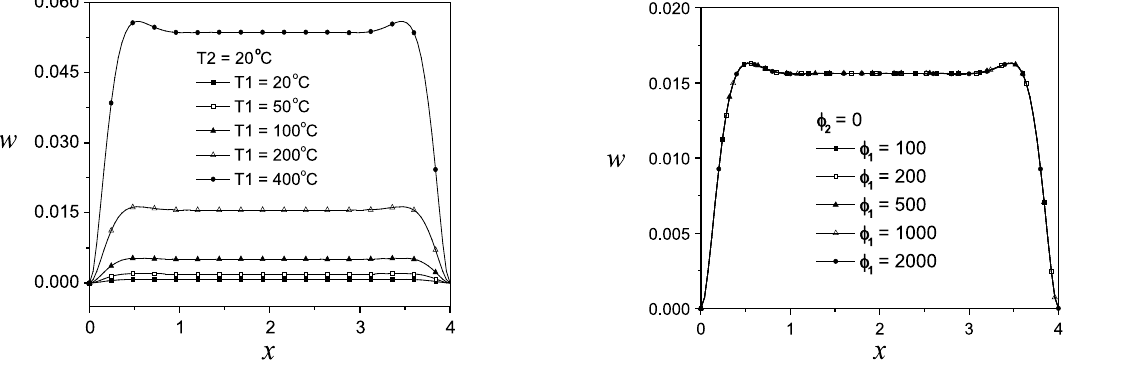
Fig. 6. Deflection of the mid-plane for the clamped supported FGPM cylindrical shell imposed by different thermal loads ( q = 1 MPa, a = 1 m, L = 4 m, a/h = 20 , φ 1 = 1000 , φ 2 = 0 , n = 1 ).